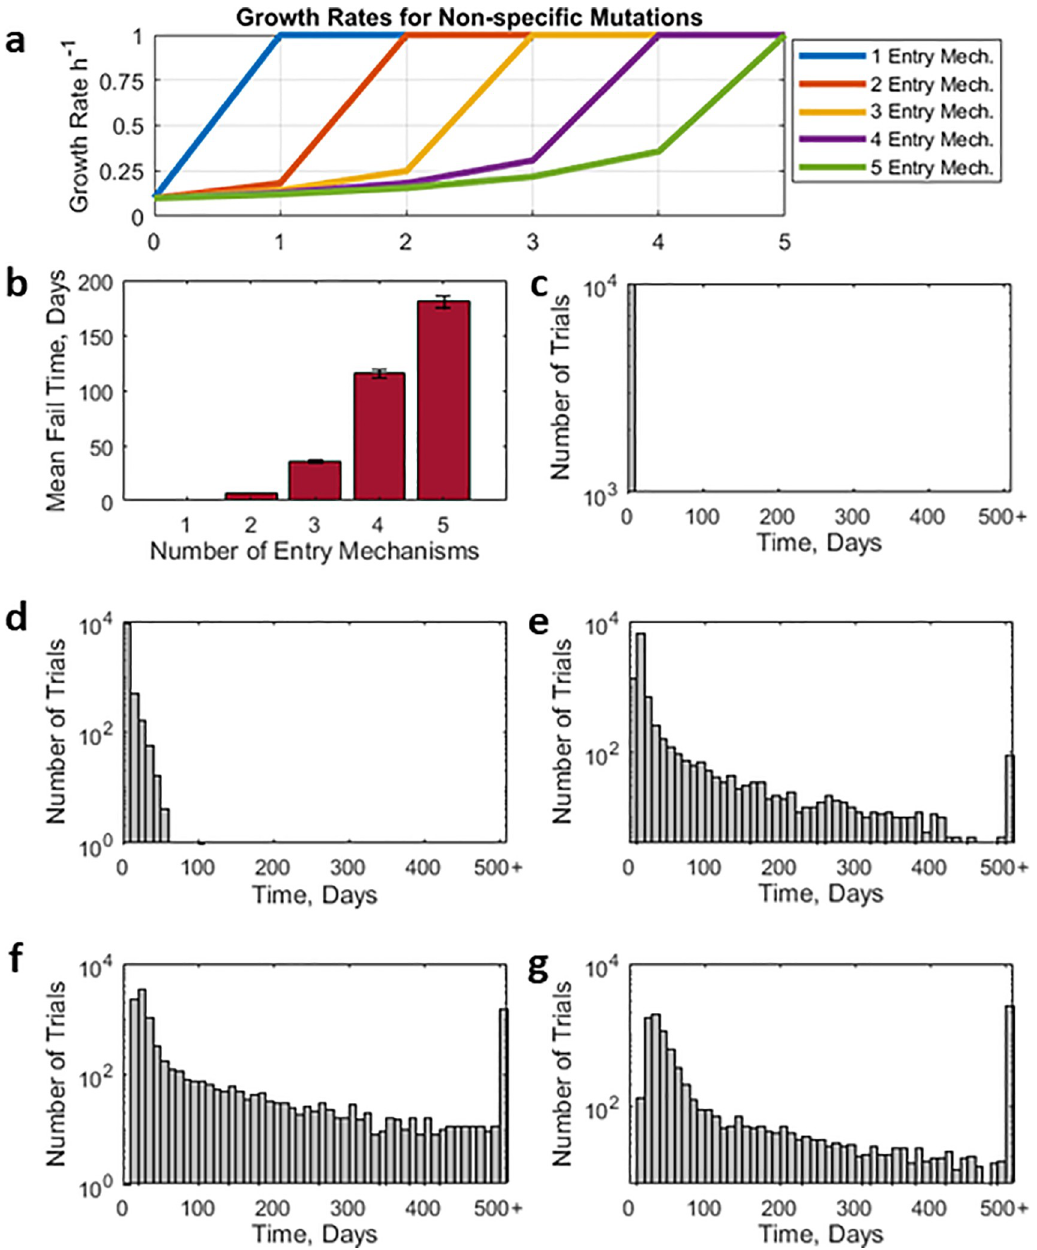
Fig 2. Therapy Failure Time for Randomly Constructed Specific Mutants Caption: a. Functional dependence of growth rate of pathogen vs number of mutations that inactivate entry mechanisms. Curves represent settings with maximum of 1,2,3,4, or 5 delivery mechanisms. b. shows mean-time of therapy failure for maximum of one to five entry mechanisms. Error bars are � 1 standard deviation ffiffiffiffiffiffiffiffiffiffiffiffiffiffiffiffiffiffiffiffiffi number of trials